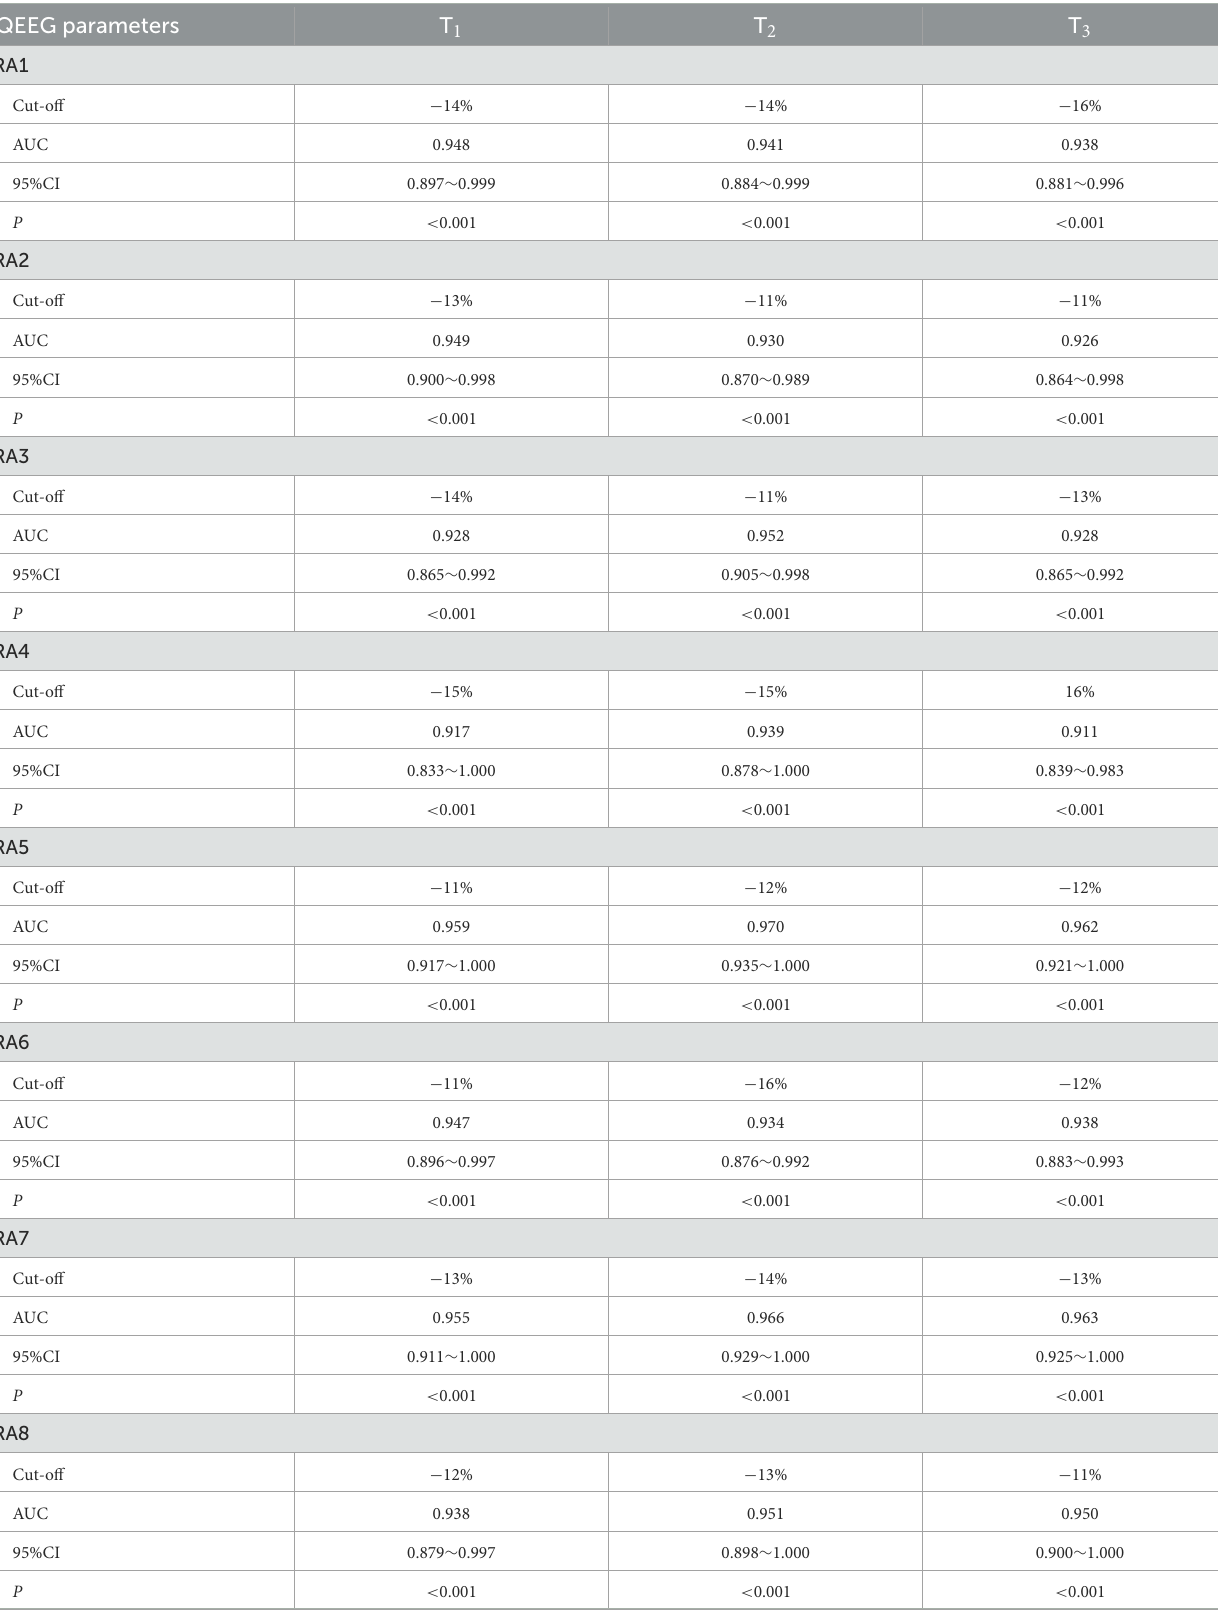
TABLE 2 RA comparison of different leads at different time points on the surgical side undergoing CEA. QEEG